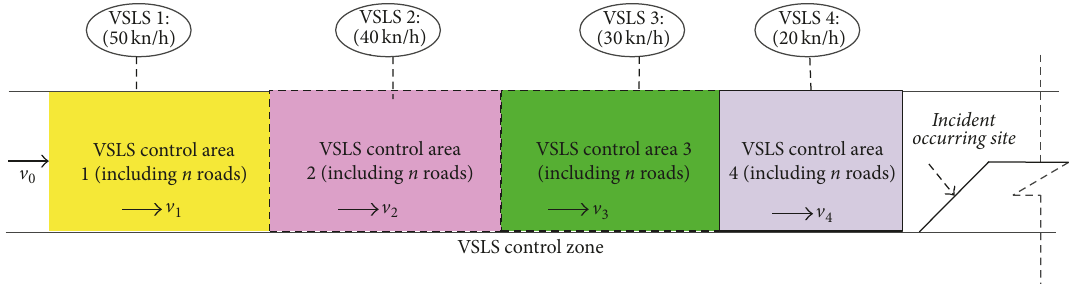
Figure 9: VSLS distribution of each control area.